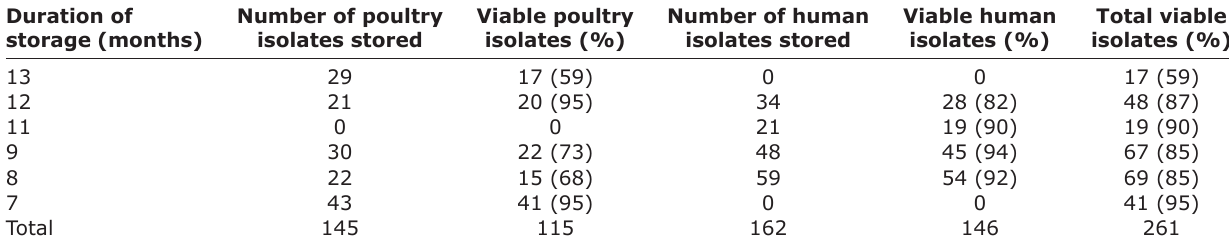
Table-2: Recovery rate of Campylobacter isolates within 7-13 months of storage at − 20°C. Duration of Number of poultry storage (months) isolates